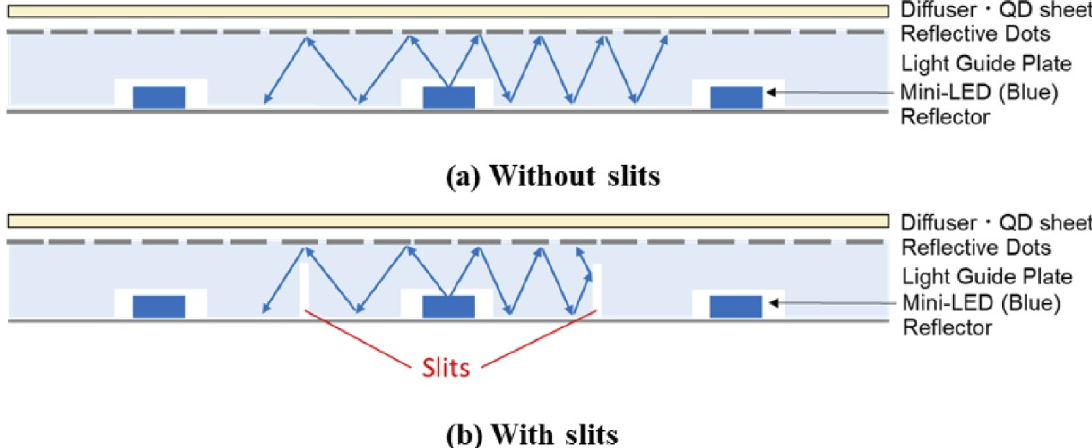
Figure 7. Difference in structure ( a ) without and ( b )with slits [33].